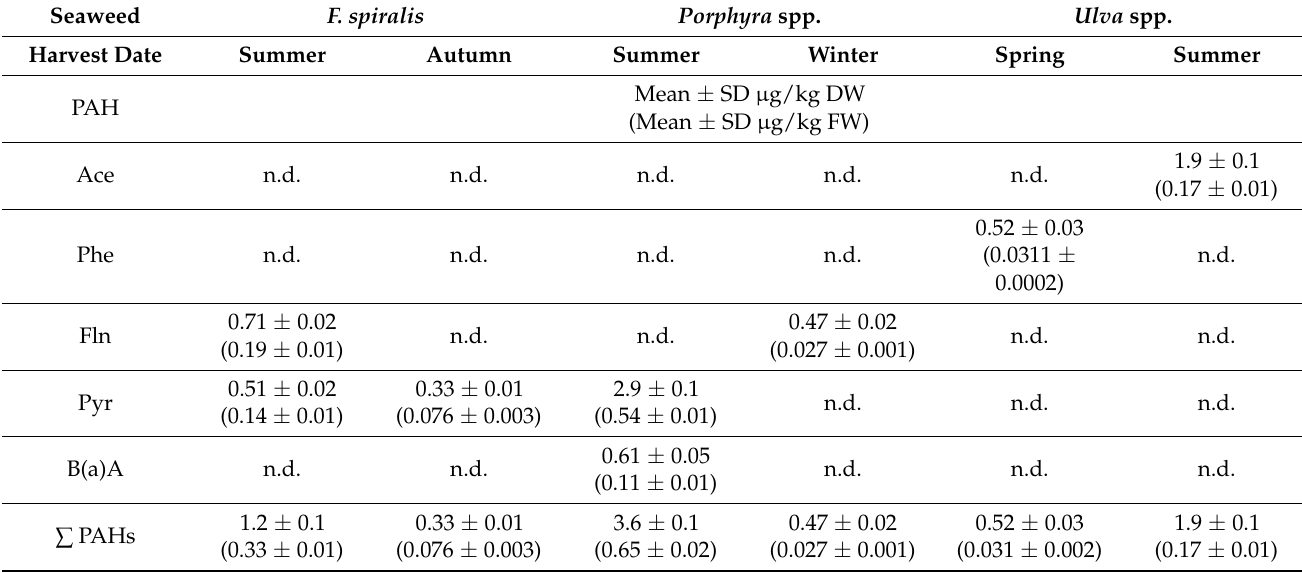
Table 2. PAHs levels detected in the seaweeds µ g/kg DW ( µ g/kg FW). Seaweed F. spiralis